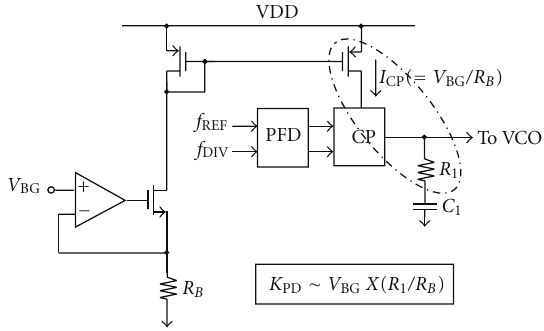
Figure 6: CP biasing for uniform PD gain.